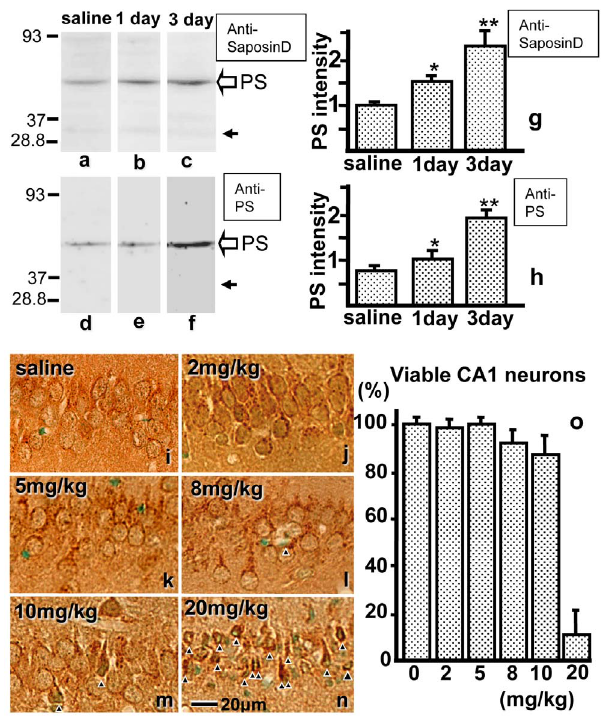
Figure 1. a–h: Crude hippocampal extracts from normal controls and from animals injected with kainic acid (KA) after 1 and 3 days were examined using anti-saposin D antiserum (a, b, c) and anti-PS IgG (d, e, f). When stained with anti-saposin D antiserum, an intense , 69-kDa band (open arrow), which likely corresponds to prosaposin (PS), increased in intensity after KA treatment (b, c). Conversely, a faint , 29-kDa band (closed arrow), which likely corresponds to di- or tri-saposin, did not change in intensity. When stained with anti-PS (d, e, f), the single band observed at , 69 kDa (arrow), which likely corresponded to PS, increased in intensity after KA treatment. The intensities of the protein bands of PS were quantified using the NIH Image software (g, h). i-n: PS-IR in the hippocampal CA1 neurons from rats injected with saline (i), or 2 (j), 5 (k), 8 (l), 10 (m), or 20 (n) mg/kg KA at 7 days after injection. Arrowheads indicate damaged neurons. o: Pyramidal neurons with intact morphology along 1-mm linear length fields of hippocampal CA1 were counted, and the percentage of viable neurons in the hippocampal CA1 region after injection of saline or KA was calculated. Bar 5 20 m